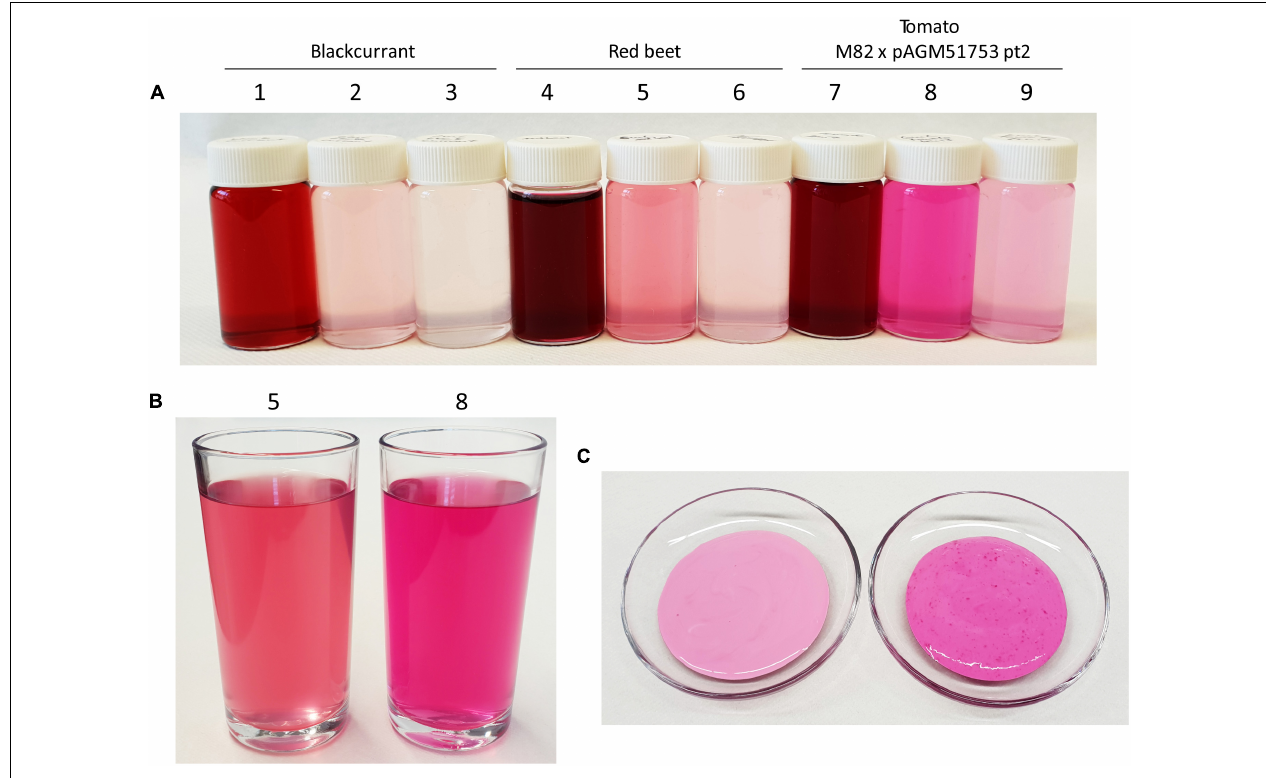
FIGURE 8 | Use of betalain-containing tomato juice as food colorant. (A) Preparation of lemonade colored with blackcurrant juice, red beet or betanin-producing tomatoes. The composition of the bottles in (A) is as follow: (1) 4.3 g juice + 50 g sugar/100 ml, (2) 0.26 g juice + 3 g sugar + 3 ml lemon juice/100 ml, (3) 0.09